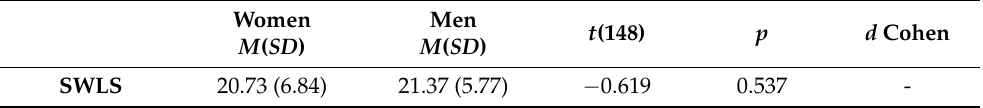
Table 3. The differences between women and men in terms of life satisfaction.